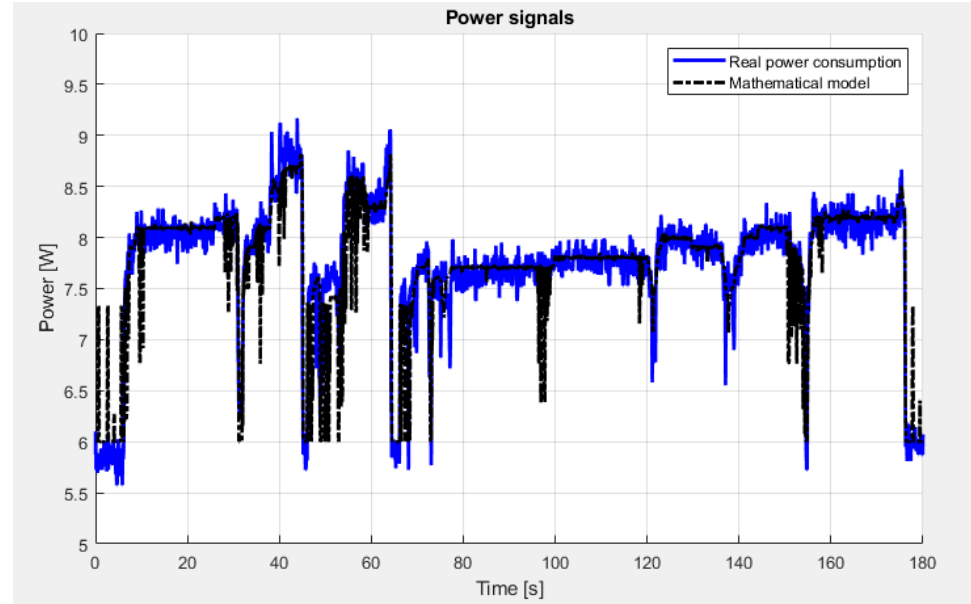
Figure 8. The real and the estimated power signals on the Floor panels. The calculated outcomes are shown in Table 4. Table 4. The calculated values of quality factors for the mathematical model of the differential drive robot.